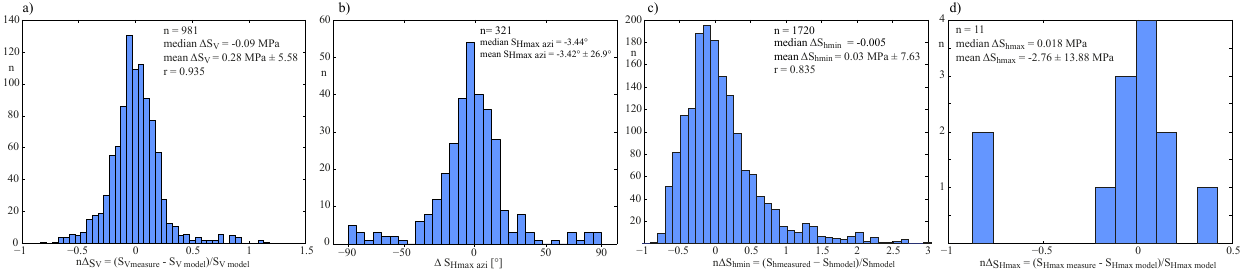
Figure 14. Distribution plots of the best-fit model, the number of data, the median, the mean, the standard deviation (SD) and the Pearson product-moment correlation coefficient ( r ) for the most n(cid:49)S or (cid:49)S are indicated in the histograms. (a) The histogram of the normalized (cid:49)S V displays a nice Gaussian distribution. (b) The histogram of the (cid:49)S Hmax azimuth data displays one major cluster around zero, with a range from − 40 to 40 ◦ ; a second smaller cluster ranges in orientation between − 50 ◦ over ± 90 ◦ to 60 ◦ , with the highest peak by about ± 90 ◦ . (c) The normalized (cid:49)S hmin magnitudes display a positive screwed distribution. (d) The normalized (cid:49)S Hmax magnitude histogram for the 13 available data displays two negative outliers (the two shallow (overcoring) data). However, the 11 calculated data are arranged around zero.